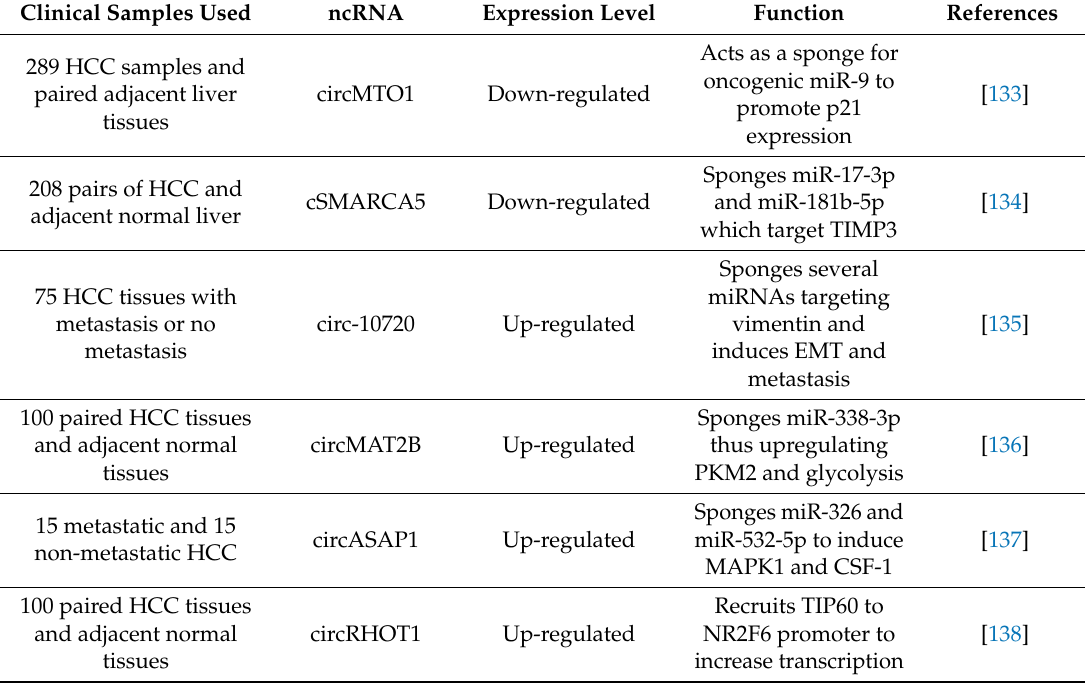
Table 3. Examples of deregulation of circular RNAs (circRNAs) in